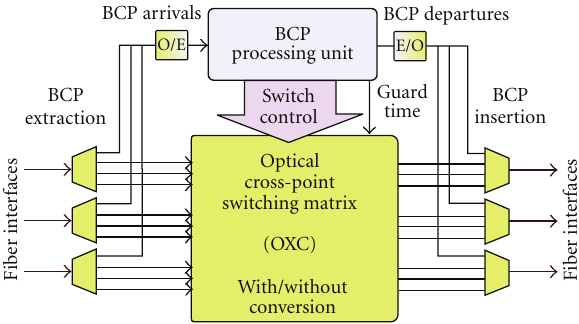
Figure 2: Functional blocks of an OBS core